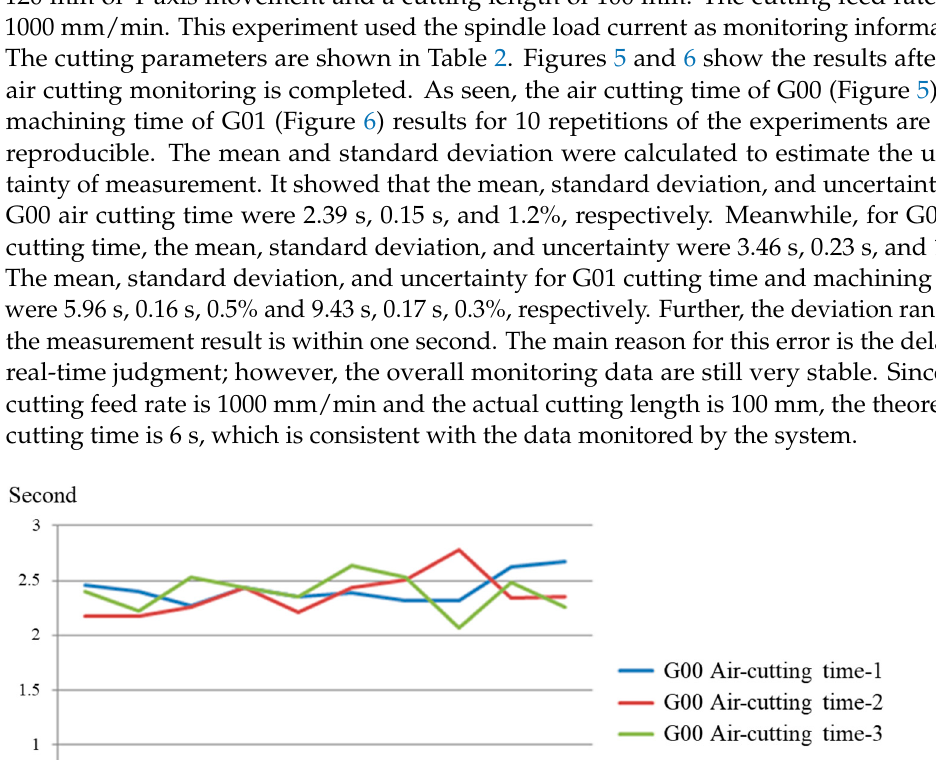
Figure 6. G01 cutting time and machining time monitoring result. 5.2. Vibration Signal Diagnosis Method For the monitoring experiment, based on cutting vibration signals as the judgment basis, the experiment parameters are shown in Table 2. The accelerometer is installed on the vise, and the cutting path is the same as in the previous experiment. The experiment result data are shown in Table 3. It can be seen that the monitoring results of the three cuttings are similar. The mean, standard deviation, and uncertainty of cutting time, air cutting time, and machining time were 10.443 s, 0.048 s, 0.27%; 11.941 s, 0.046 s, 0.22%; 22.384 s, 0.016 s, 0.04%, respectively. The total machining time is about 22.4 s, and the cutting time is about 10.4 s. Since the feed rate is 600 mm/min and the cutting length is 100 mm, the theoretical cutting time should be 10 s. The difference of 0.4 s is perhaps because of signal processing time and judgment calculation time; however, this deviation value is still in the acceptable range.